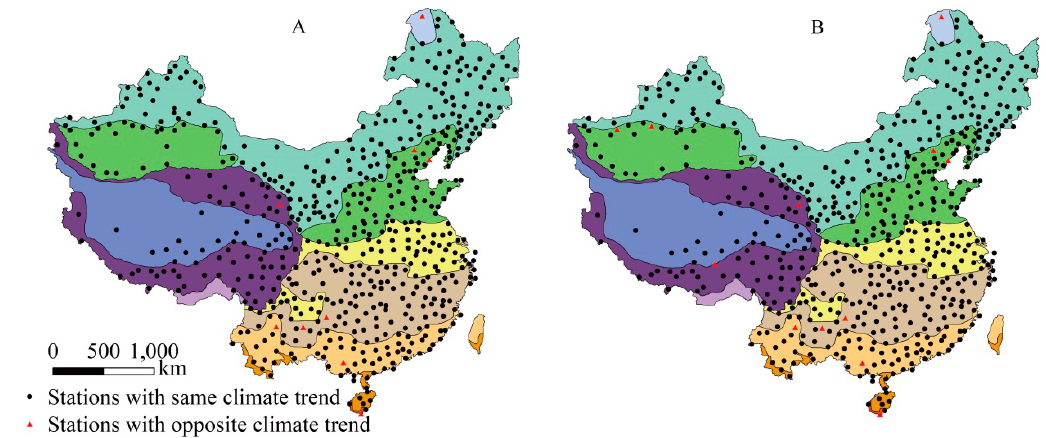
Figure 15. Climate trend of ≥ 0 ◦ C ( A ) and ≥ 10 ◦ C ( B ) active accumulated temperature.